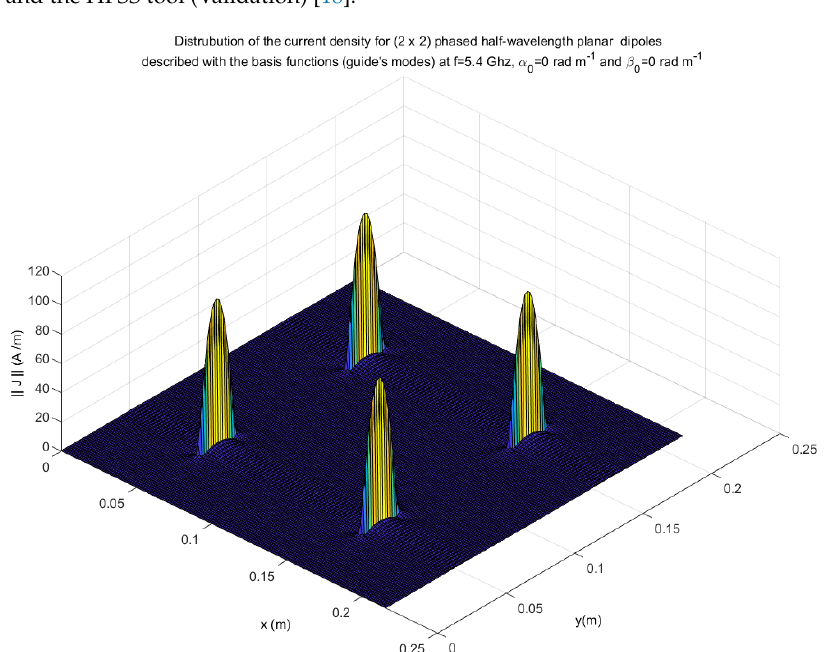
Figure 5. Distribution of the current density for (2 × 2) phased half-wavelength planar dipoles described with the guide’s modes functions at f = 5.4 Ghz, α 0 = 0 rad m − 1 and β 0 = 0 rad m − 1 (MoM-GEC method)